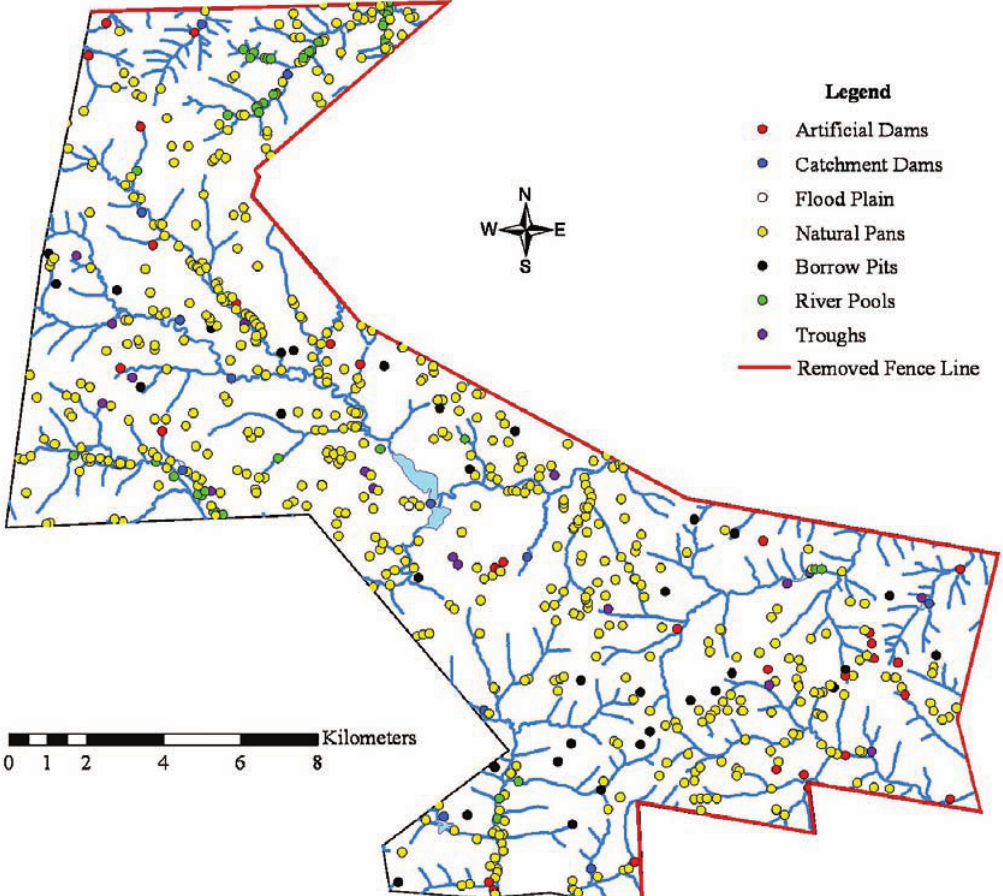
Fig. 4. The distribution of surface water on the Manyeleti Game